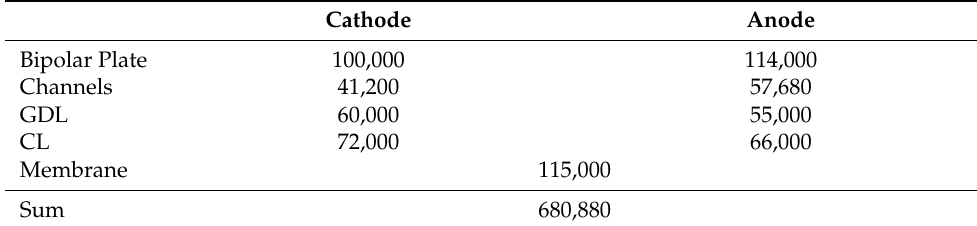
Figure 1. ( a ) Single-channel mesh with symmetry boundary faces. Terminal boundary faces were also used to apply cooling BCs. ( b ) Isometric view of channel model mesh. Extruded in/outlet sections of the channels are not shown. Length of channel model: 1.174m. Table 1. Number of computational cells of single-channel model approach.